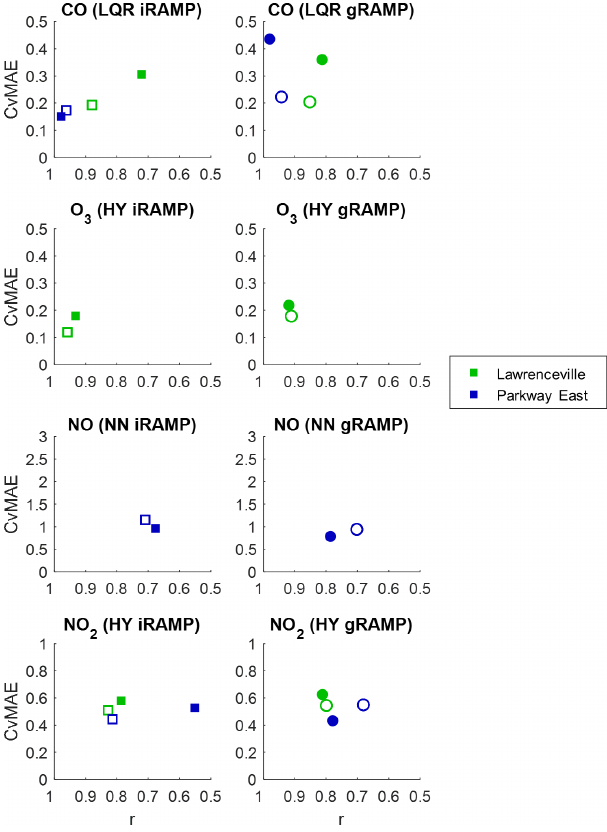
Figure 4. Comparative performance of individual and general mod- els for RAMPs deployed to ACHD monitoring stations (filled mak- ers), compared to the performance of the same RAMPs at the CMU site (hollow markers). For example, a filled green marker indicates the performance of a RAMP at the Lawrenceville site, while a hol- low green marker indicates the performance of that same RAMP when it was at the CMU site. The modeling algorithm used for each gas corresponds to the most consistent algorithm identified among the models depicted in Fig. 3: limited quadratic regression (LQR) for CO, neural network (NN) for NO, and hybrid random forest– linear regression models (HY) for NO 2 and O 3 . Models are trained on data collected at the CMU site during 2017; performance shown for the CMU site (hollow marker) is based on the testing data for the corresponding RAMPs collected at that site. Proximity to the lower-left corner of each figure indicates better performance.